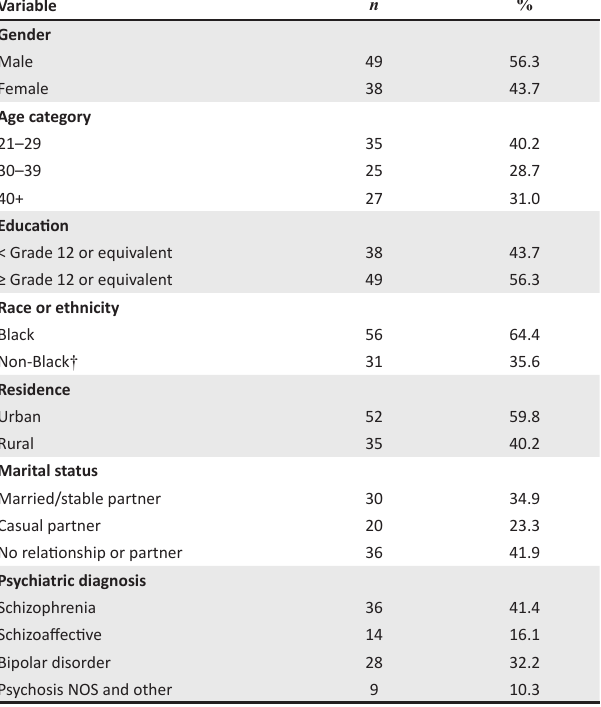
TABLE 1: Demographic and clinical characteristics ( N = 87).